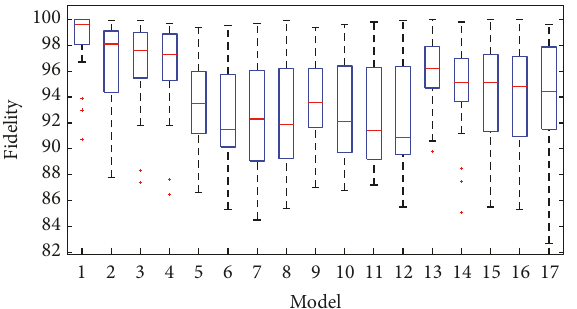
Figure 8: Boxplots of the average fidelity of the extracted rulesets ( 𝑦 -axis) with respect to each model ( 𝑥 -axis).